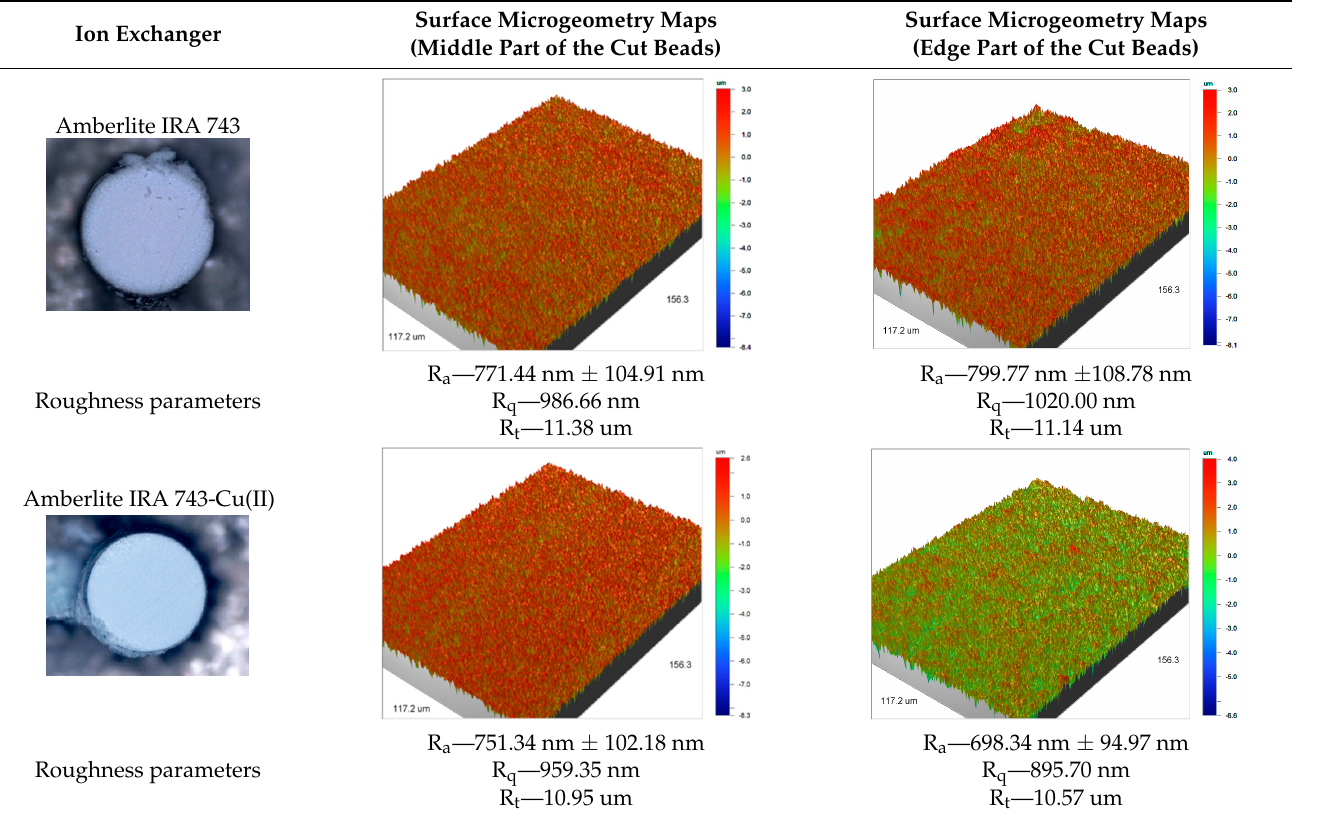
Table 4. Surface microgeometry and roughness parameters of Amberlite IRA 743 before and after the sorption of Cu(II). Surface Microgeometry Maps Ion Exchanger ( Middle Part of the Cut Beads ) Amberlite IRA 743